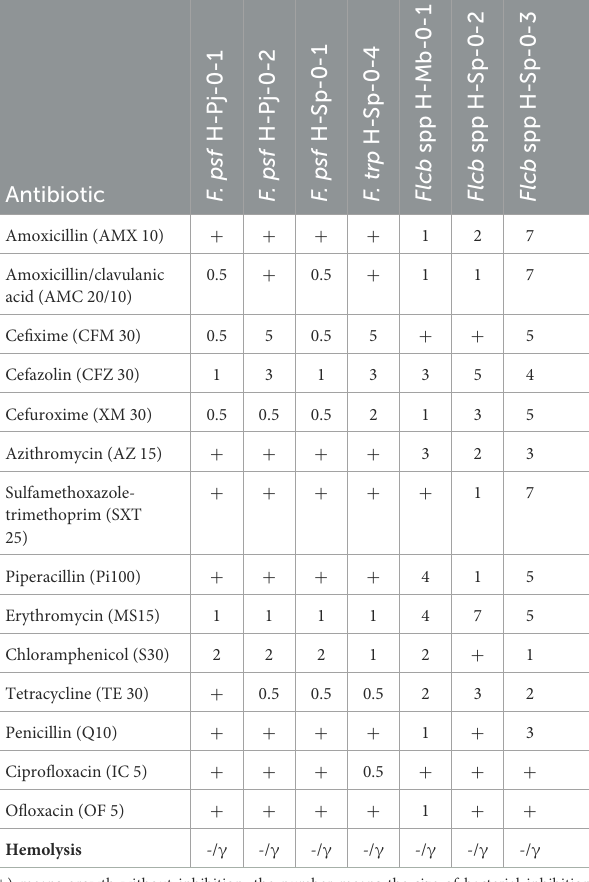
TABLE 4 Antibiogram results for bacteria isolated from stingless bee honey.